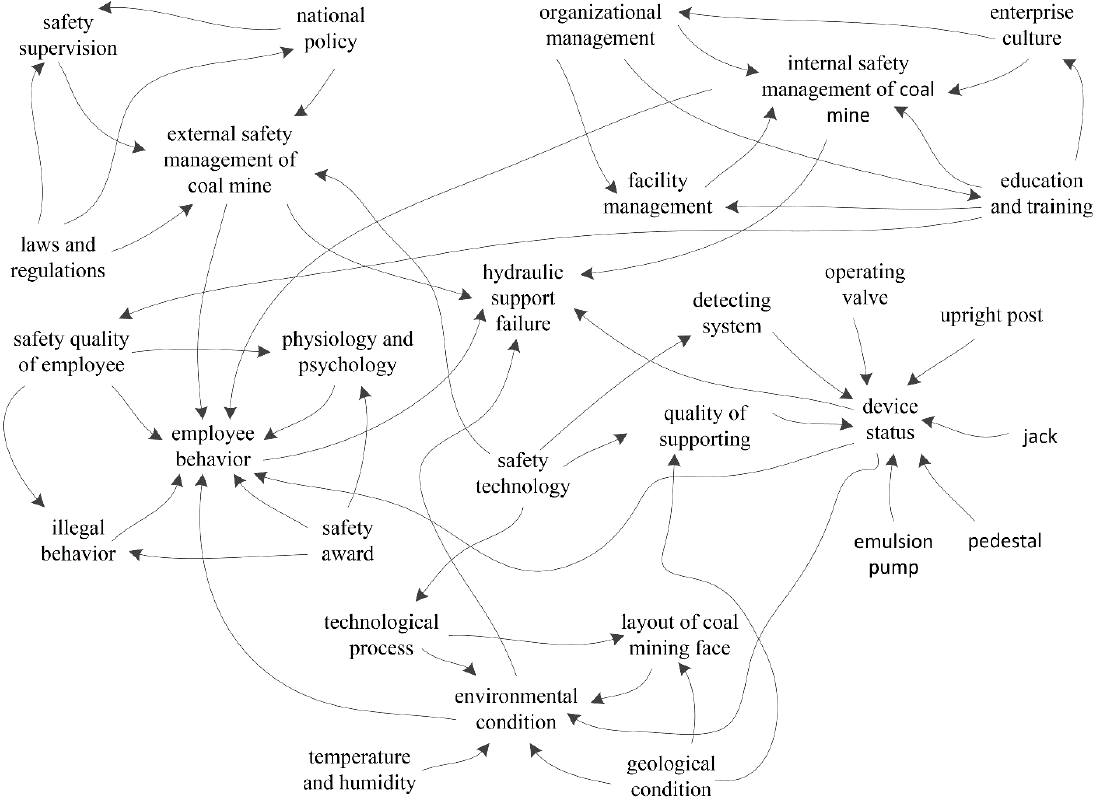
Figure 5. Butterfly effect in the evolutionary process of hydraulic support failure.